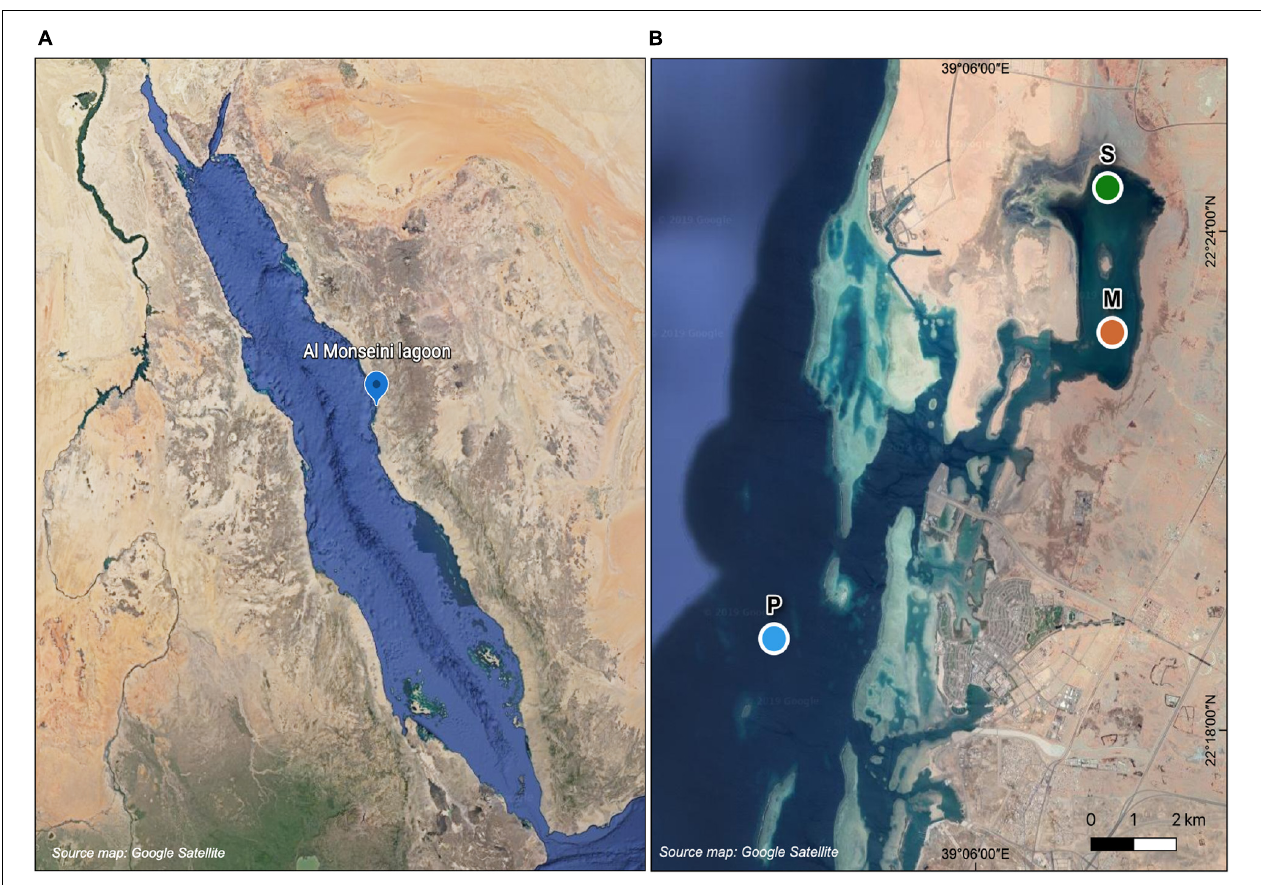
FIGURE 1 | Map of the Red Sea showing the study site (A) and detailed location of the sampling stations at Al Monseini coastal lagoon and nearby coastal waters (B) : Seagrass-dominated site (S), Mangrove-dominated site (M), and Phytoplankton-dominated site